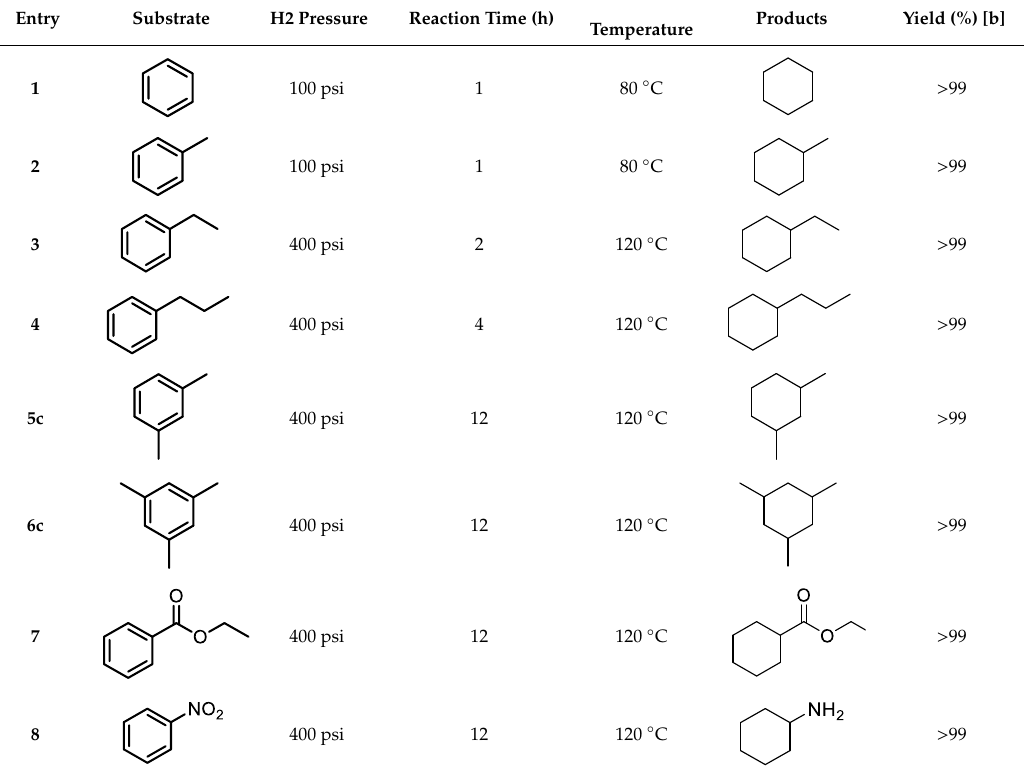
Table 1. Reduction of aromatic compounds mediated by the Ru@M-Ethylene PMO NP catalyst. [a]. Entry Substrate H 2 Pressure Reaction